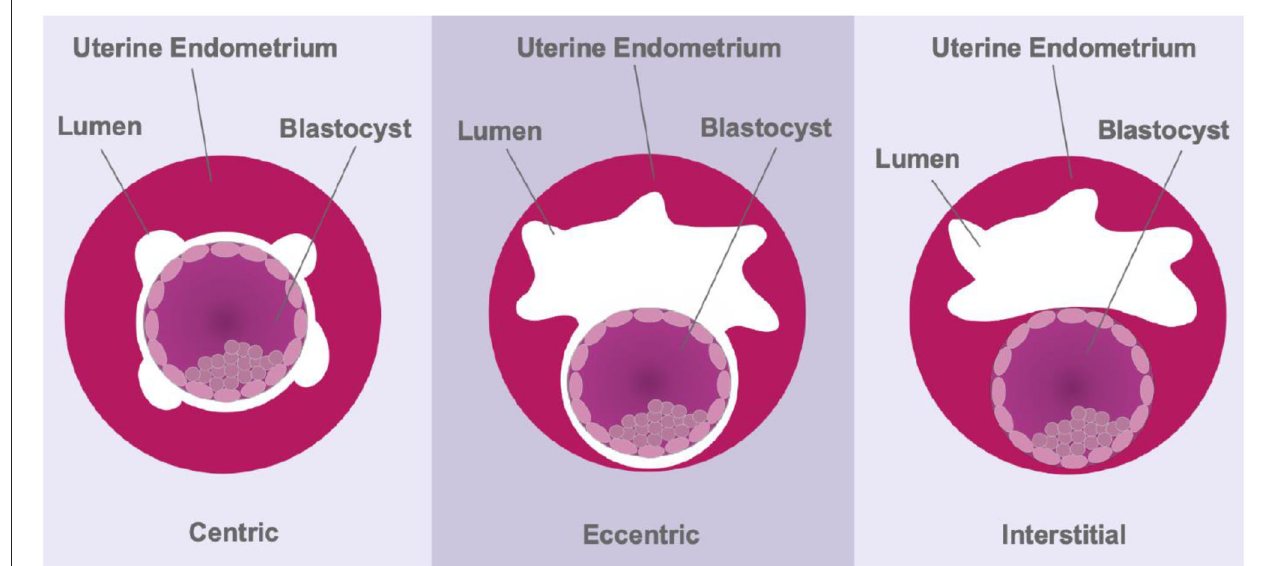
FIGURE 3 | Schematic representing the three modes of implantation. During centric implantation, the embryo is superficially attached to the uterine epithelium and trophoblasts do not invade the endometrium (cows and ewes). Eccentric implantation involves the formation of a tear-drop shaped cavity within the endometrium with a moderate degree of trophoblast invasion (most rodents). During interstitial implantation, the blastocyst completely embeds itself within the endometrial stroma with trophoblasts invading to the basal endometrium